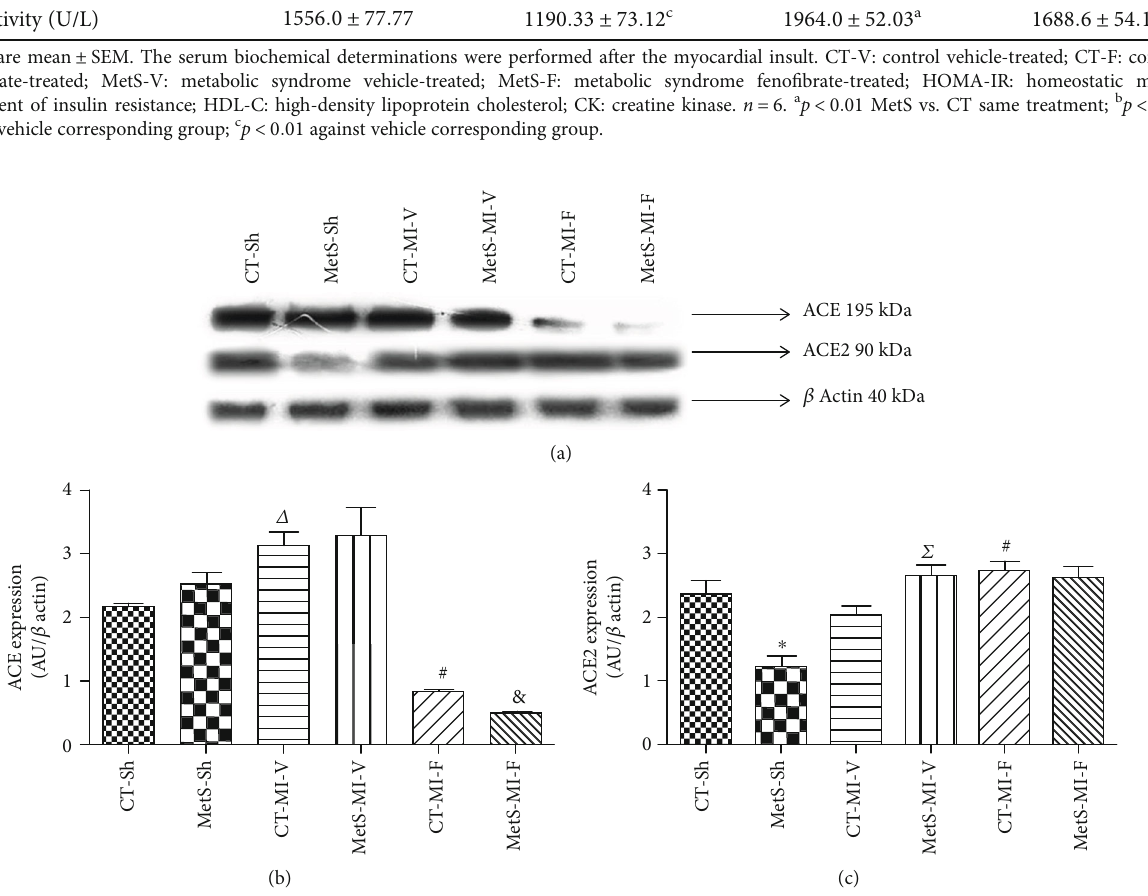
Figure 1: E ff ect of feno fi brate on the expression of renin-angiotensin-converting enzyme (ACE) and ACE2. The expression was evaluated in the left ventricles from the control (CT) and metabolic syndrome (MetS) rats subjected to sham (Sh) or myocardial infarction (MI) and treated for two weeks with either vehicle (V) or feno fi brate (F). (a) Representative western blot analysis. (b) ACE protein expression. (c) ACE2 protein expression. Data represent mean ± SEM ( n = 5 per group). ∗ p < 0 : 05 vs. CT-Sh; Δ p < 0 : 05 vs. CT-Sh; Σ p < 0 : 05 vs. MetS-Sh; # p < 0 : 05 vs. CT-MI-V; & p < 0 : 05 vs. MetS-MI-V. Analysis of variance-Newman-Keuls.